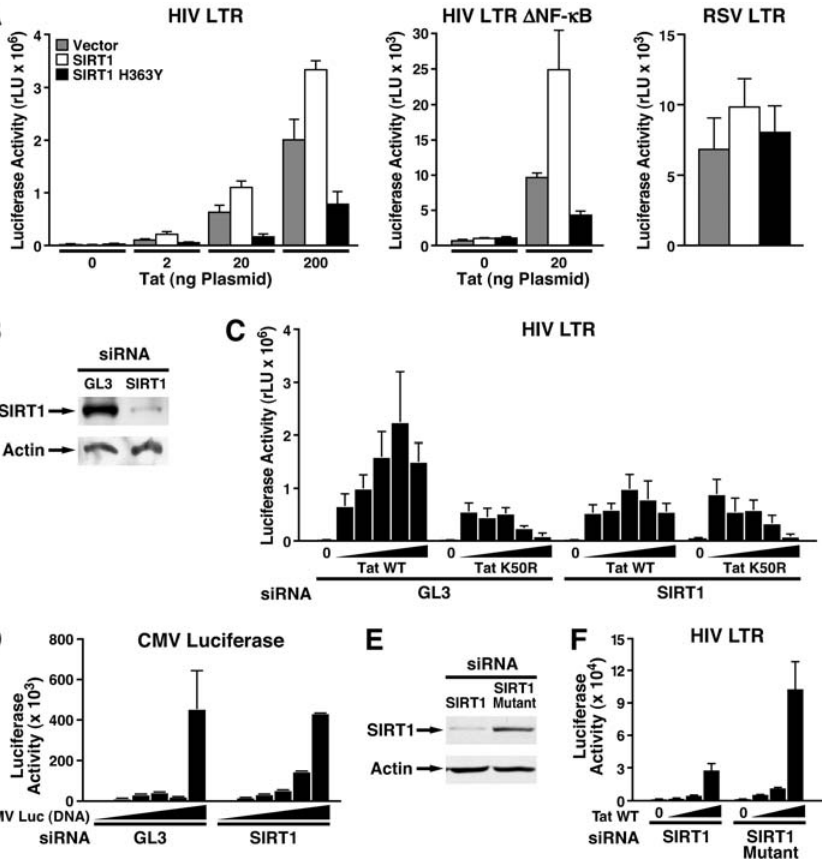
Figure 3. SIRT1 Is a Positive Cofactor for Tat Transactivation (A) Cotransfection of SIRT1 or the catalytically inactive SIRT1 mutant SIRT1H363Y with the HIV LTR luciferase construct and increasing amounts of a Tat expression vector (RSV-Tat: 0, 2, 20, and 200 ng), an HIV LTR luciferase construct containing mutated binding sites for the transcription factor NF- j B and RSV-Tat (20 ng), or with an RSV-luciferase construct (200 ng) in HeLa cells. The average of three experiments is shown ( 6 standard error of the mean [SEM]). (B) WB analysis of HeLa cells 72 h after transfection of siRNAs directed against SIRT1 or GL3 control siRNAs. (C) Cotransfection of the HIV LTR luciferase construct with increasing amounts of CMV-Tat or CMV-TatK50R (0, 50, 100, 200, 400, and 800 ng) 48 h after transfection of double-stranded siRNAs directed against SIRT1 or GL3 control siRNAs in HeLa cells. Luciferase activity was measured 24 h after plasmid transfection and 72 h after siRNA transfection. Note that all luciferase reporter vectors used in this study are based on the pGL2 luciferase vector, which is not affected by GL3-specific siRNAs [36]. The average of three experiments is shown ( 6 SEM). (D) The transcriptional activity of increasing amounts of the CMV-luciferase reporter (0, 50, 100, 200, 400, and 800 ng) was similar in SIRT1 knockdown or GL3-treated control cells. The average of two experiments performed in duplicate is shown ( 6 SEM). (E) WB of endogenous SIRT1 or actin 72 h after transfection of siRNA directed against SIRT1 or mutated SIRT1 siRNA. (F) Cotransfection of the HIV LTR luciferase with increasing amounts of CMV-Tat (0, 2, 20, and 200 ng) in HeLa cells pretransfected with wild- type or mutant SIRT1 siRNA oligonucleotides as described in (C). WT,